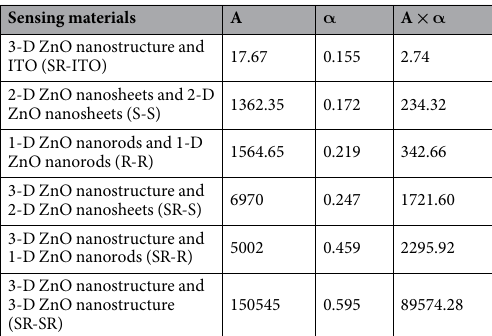
Table 1. The value of the parameters for the power law in equation 1 used for modelling the response from all the different morphologies of the sensors. The model illustrates that increase in the level of structuring leads to higher sensitivity and also improves the dynamic range of the